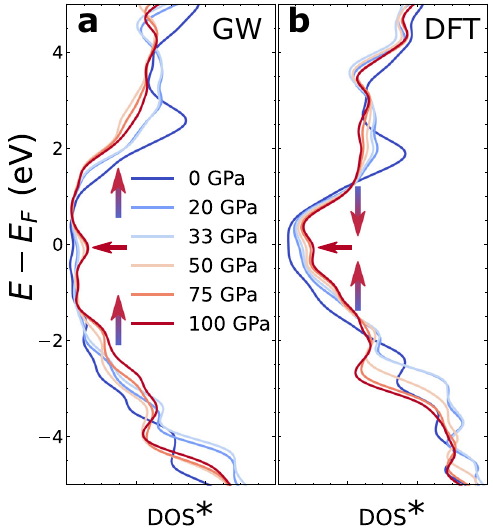
Fig. 2 Comparison of qp and DFT DOS. a qpDOS of a tBLG θ ≈ 6 ∘ as a function of pressure. The stochastic error on identifying the quasiparticle energy for the stochastic GW calculation is ~20 meV. b DFT DOS. Both DFT and qpDOS were constructed with Gaussian functions centered at each state (with broadening of 0.35 eV), for more details about qpDOS construction see Supplementary Note 2 and Supplementary Fig. 3 in the Supplementary Information fi le. (*) In Supplementary Fig. 4 of the Supplementary Information fi le we show that the DOS eigenenergies are well converged with the supercell size, we note, however, that some k -points are incom- mensurate with our real-space sampling grids, thus, some DOS features such as van Hove singularities 124 are